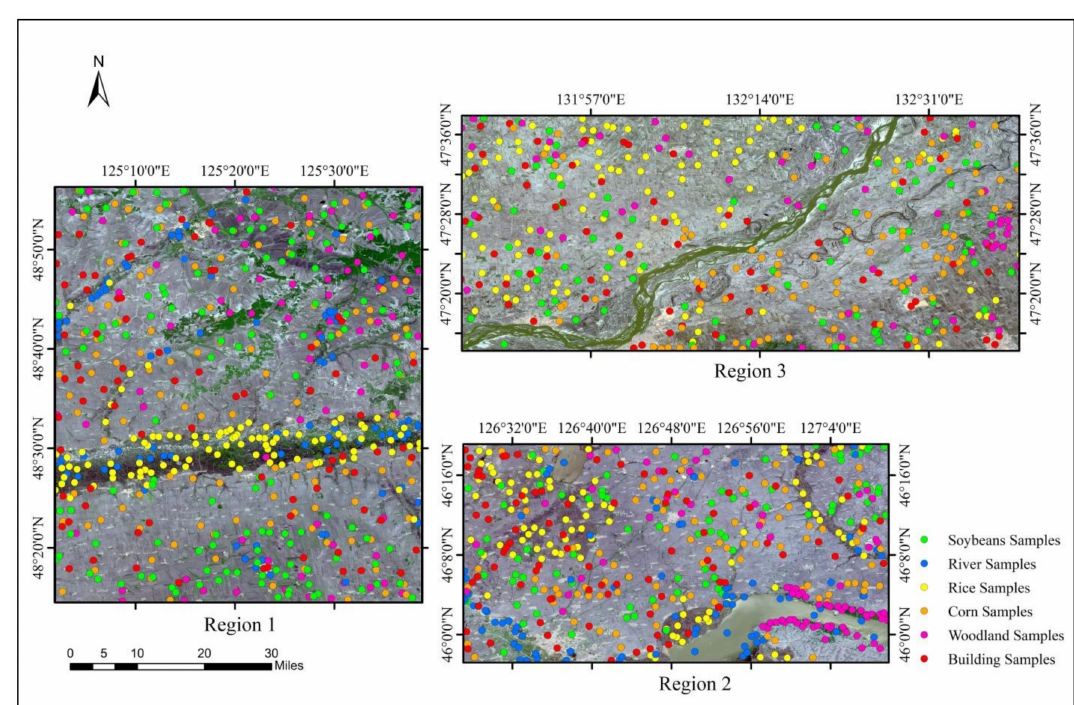
Figure 5. Distribution of training sample points in the three study areas.